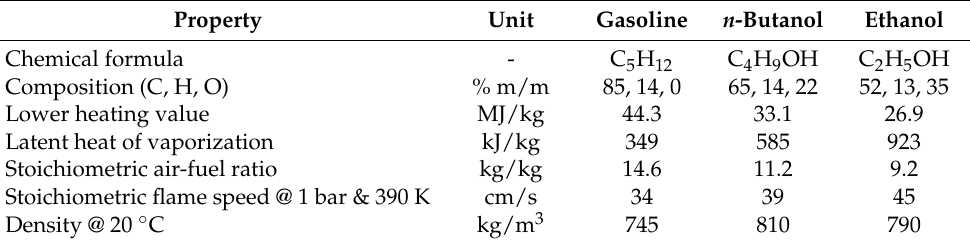
Table 1. Basic physical and chemical properties of the test fuels used in the present